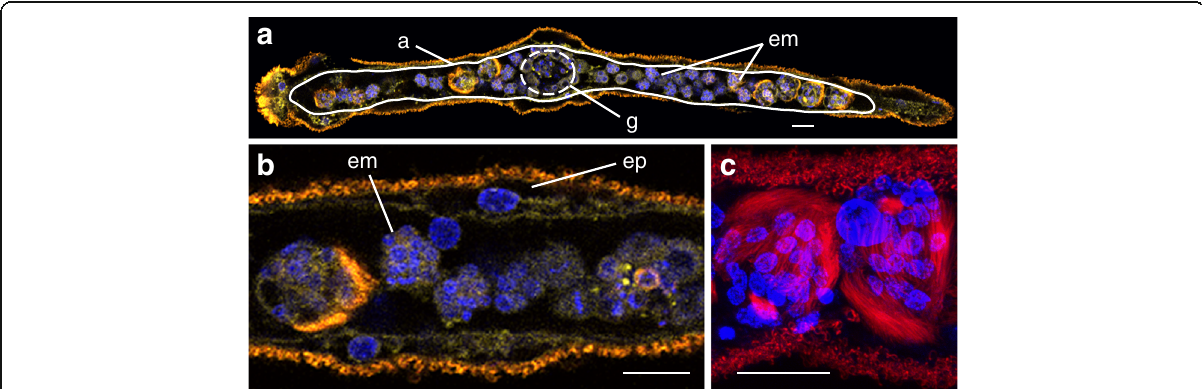
Fig. 1 Morphology of dicyemids. a Dicyemid embryos (em) develop inside the central axial cell (a, white line ), which is covered by a single layer of ciliated epidermal cells. Stained nuclei, plasma membrane, and cilia, showing the simple morphology of a sexually reproductive adult Dicyema japonicum with no coelom, gut, or other organs. Sperm cells and eggs produced by hermaphroditic gonads (g) fertilize, and embryos develop inside the central axial cell. Anterior is to the left. b The central axial cell is covered with a single layer of ciliated epidermal cells (ep). c Developing larvae produced sexually, possess long cilia for motility to reach a new host. Fluorescence: yellow, plasma membrane labeled with CellMask Deep Red; blue , nuclei labeled with DAPI; red , acetylated tubulin. Scale bar, 20 μ